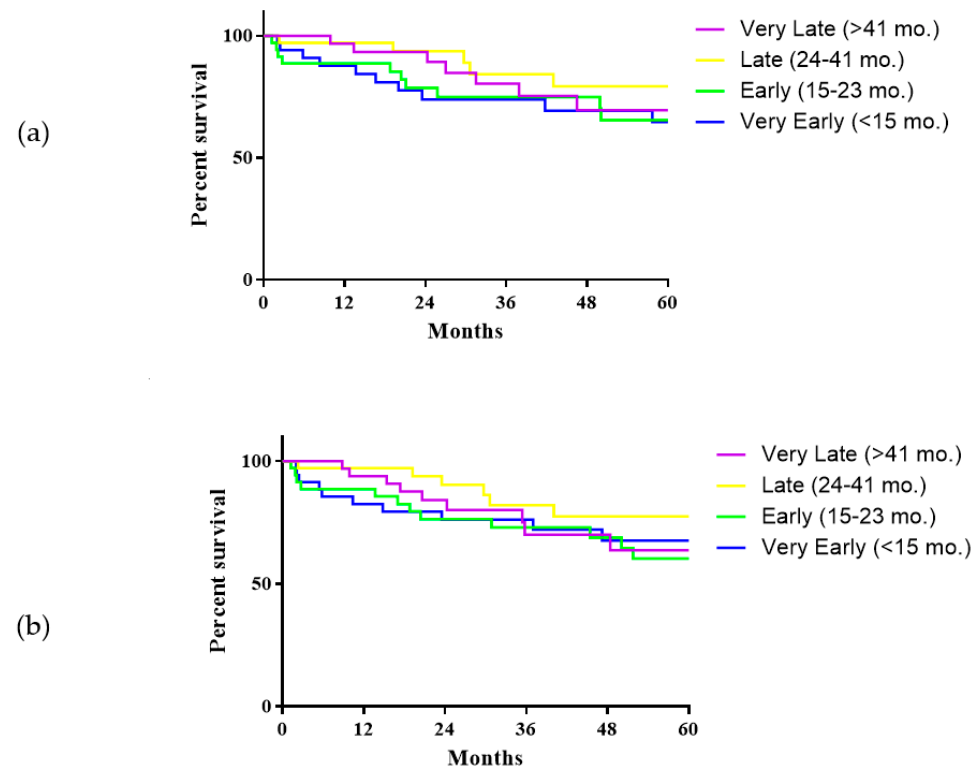
Figure 3. Overall survival ( a ) and recurrence-free survival ( b ) of patients submitted to secondary liver transplantation according to the time between hepatic resection and secondary liver transplantation. Overall survival: Very Early SLT vs. Early, p = 0.923; Very Early vs. Late, p = 0.128; Very Early vs. Very Late, p = 0.429; Early vs. Late, p = 0.192; Early vs. Very Late, p = 0.520; Late vs. Very Late, p = 0.510. Recurrence-free survival: Very Early SLT vs. Early, p = 0.717; Very Early vs. Late, p = 0.270; Very Early vs. Very Late, p = 0.929; Early vs. Late, p = 0.166; Early vs. Very Late, p = 0.880; Late vs. Very Late, p = 0.199.